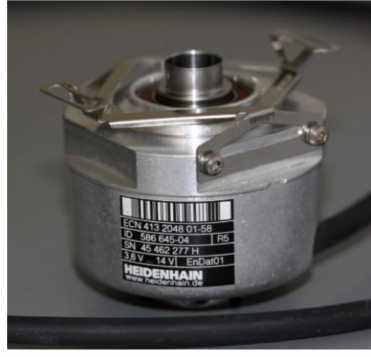
Figure A3. Absolute Encoder ECN